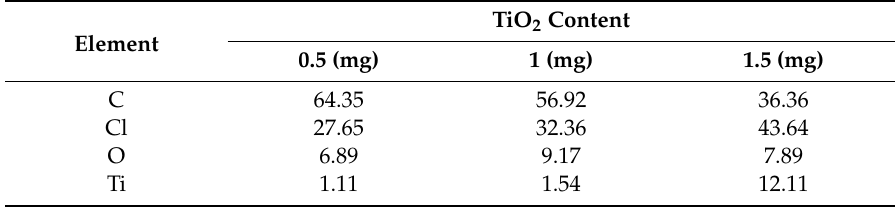
Table 2. Energy dispersive X-ray (EDX) analysis of wt.% of the elements in PVC-TiO 2 membranes. Element